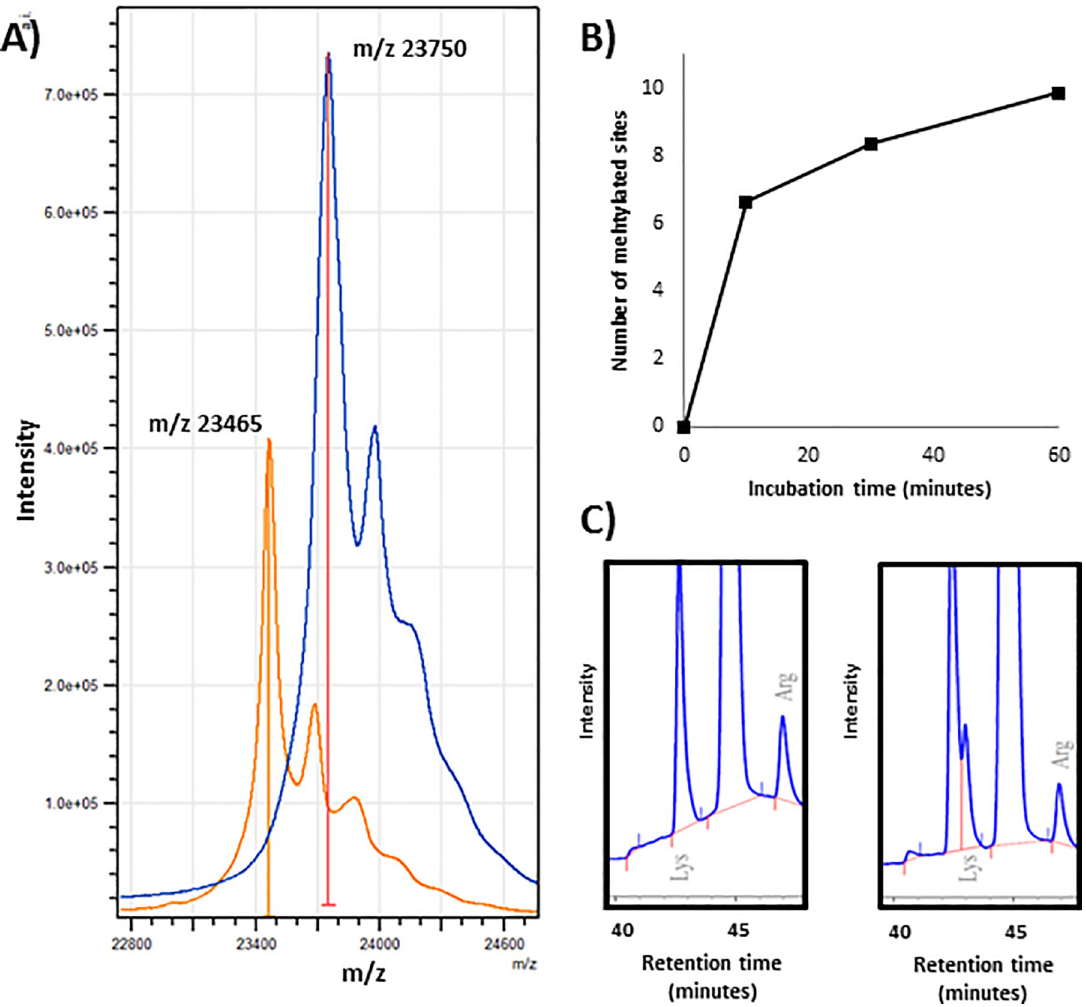
Fig 2. Extent of trypsin methylation. (A) MALDI-TOF spectra of intact Sigma IX-S in the non-methylated (Orange) and 60 min methylated (Blue) form. (B) The lysine content during methylation at pH 5.8 as a function of time measured by AAA. C) AAA chromatograms showing lysine and dimethyllysine in a non-methylated (left) and 60 min methylated (right) sample.